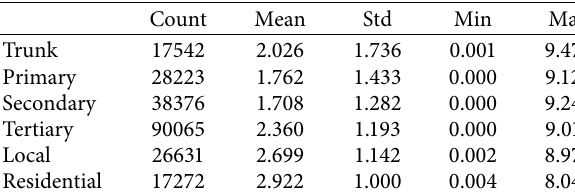
Figure 2: Hourly average speed data. Te distribution data are from 164,736 rows of data for analysis. Table 2: Types and percent of POIs. Table 3: TPI of diferent ranks of